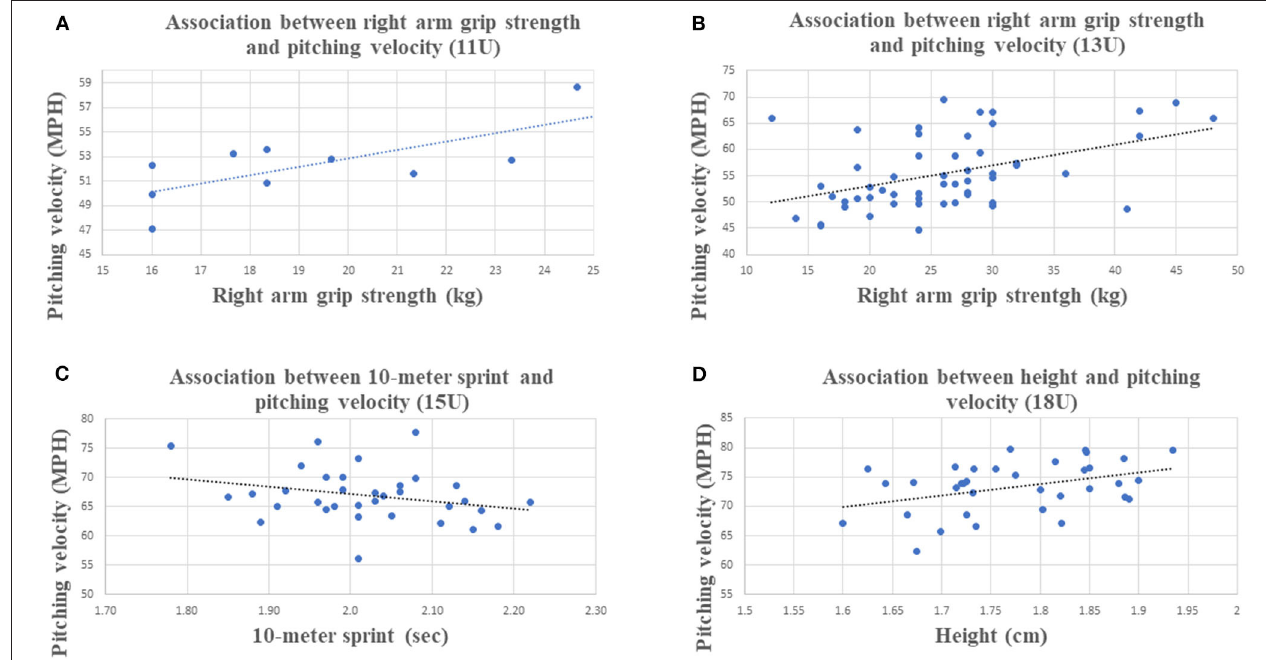
FIGURE 2 | Strongest association with PV by age categories. (A) Association between right arm grip strength and pitching velocity (11U). (B) Association between right arm grip strength and pitching velocity (13U). (C) Association between 10-m sprint and pitching velocity (15U). (D) Association between height and pitching velocity